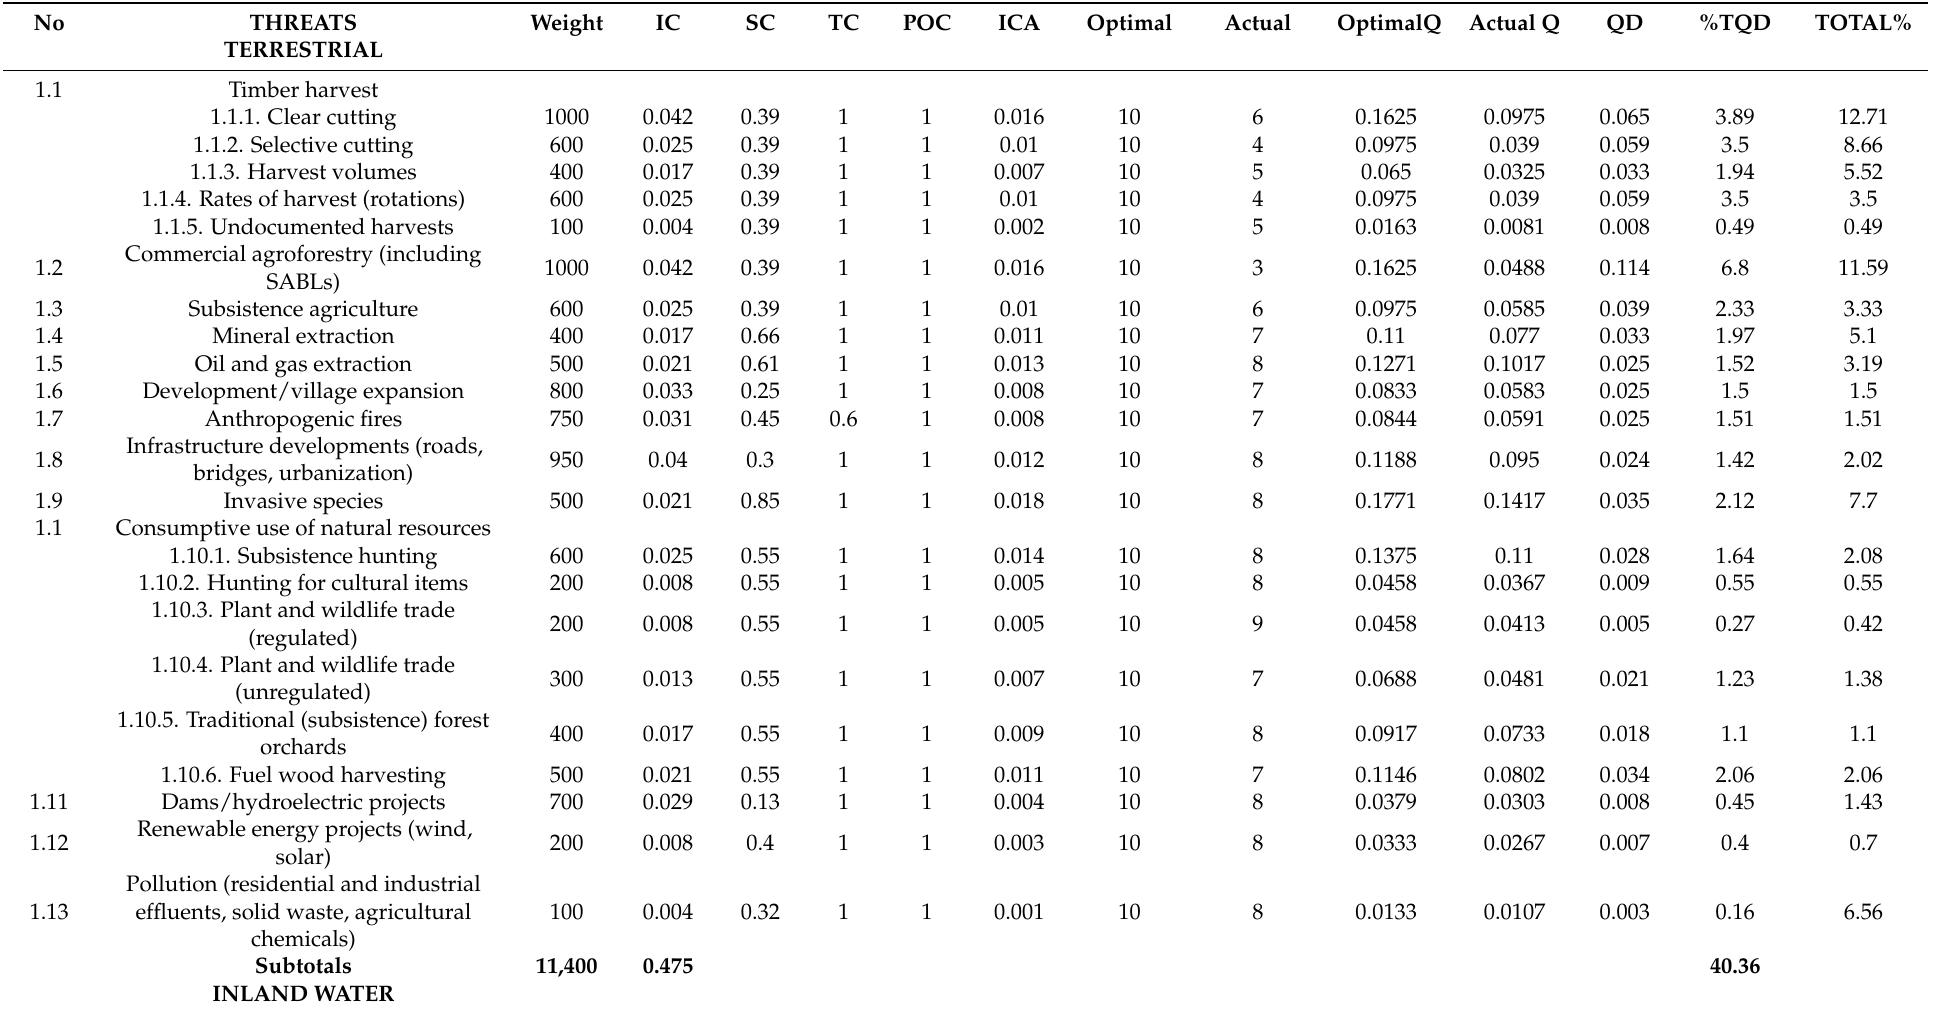
Table A1. Papua New Guinea biodiversity threat analysis complete template based on quantitative SWOT methods. Note that TOTAL % represents the total contribution of individual threats to overall biodiversity threat across all three ecosystem realms. ICA represents the product of (IC * SC * TC *